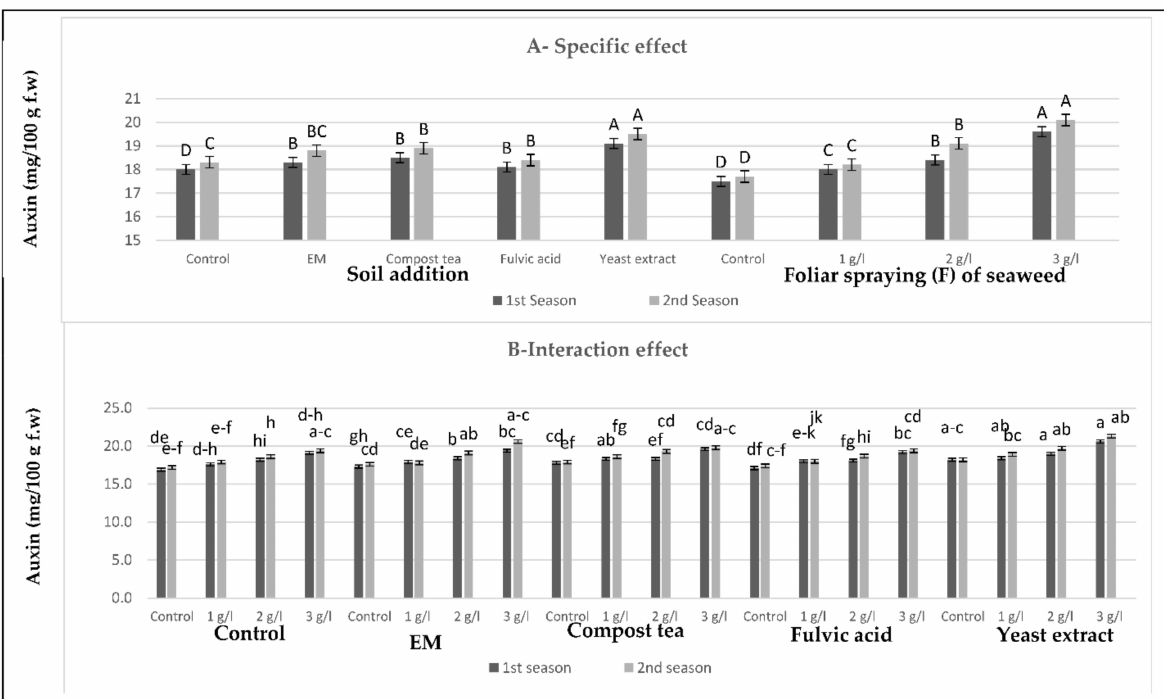
Figure 1. ( A , B ) Effects of the soil addition of EM, compost tea, fulvic acid, yeast extract, and foliar spray with seaweed extract on the auxins (mg/100 g f.w) of sweet pepper plants during the 2019/2020 and 2020/2021 seasons. Specific effects are indicated with uppercase letters and the interactions are indicated with lowercase letters, unless otherwise mentioned, according to Tukey’s multiple range test (TMRT) at p <